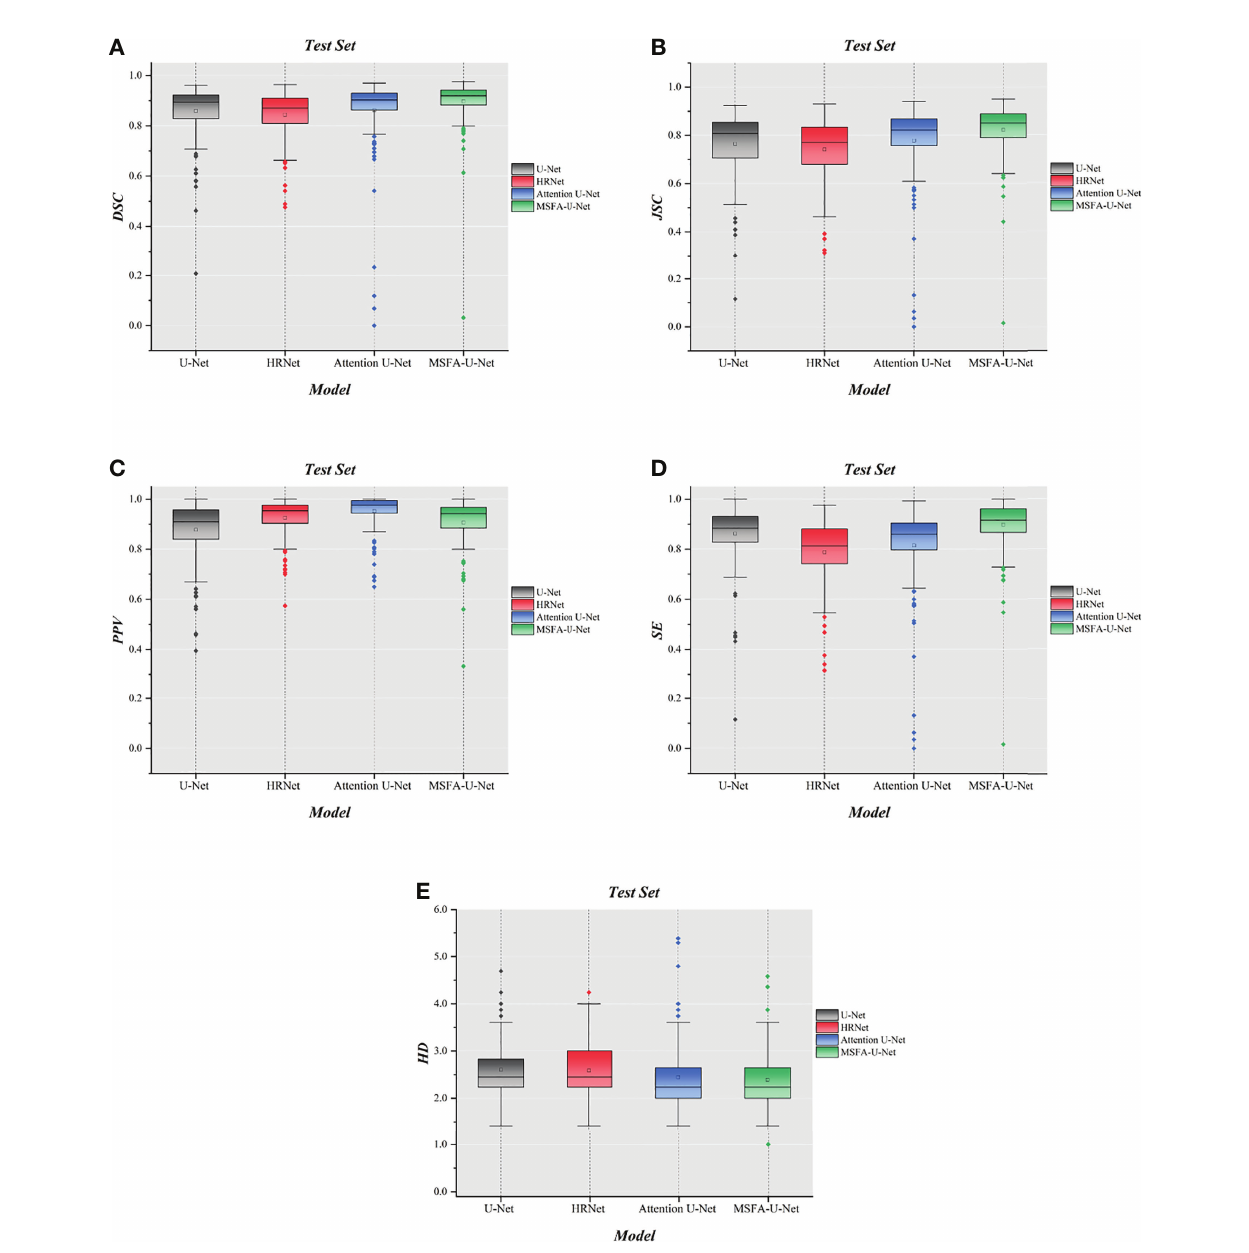
FIGURE 6 | Box plot diagrams in the test set. (A) Box plot diagram of DSC in the test set. (B) Box plot diagram of JSC in the test set. (C) Box plot diagram of PPV in the test set. (D) Box plot diagram of SE in the test set. (E) Box plot diagram of HD in the test